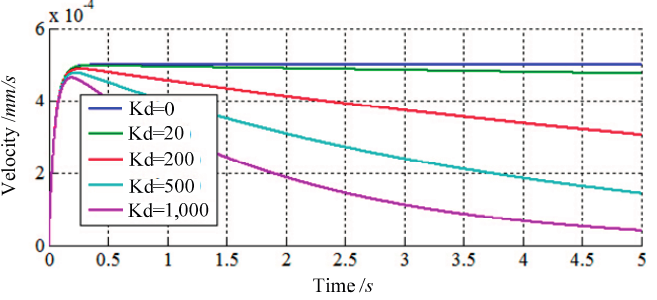
Figure 6. The responses of impedance control compensator with changing K d